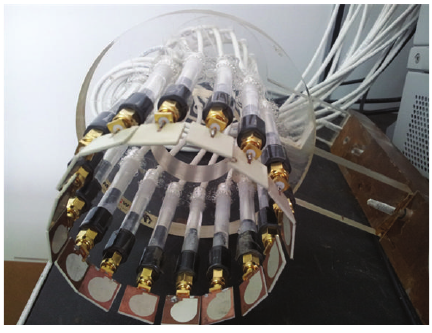
Figure 4: Experiment setup of the imaging system. Table 1: Optimized design